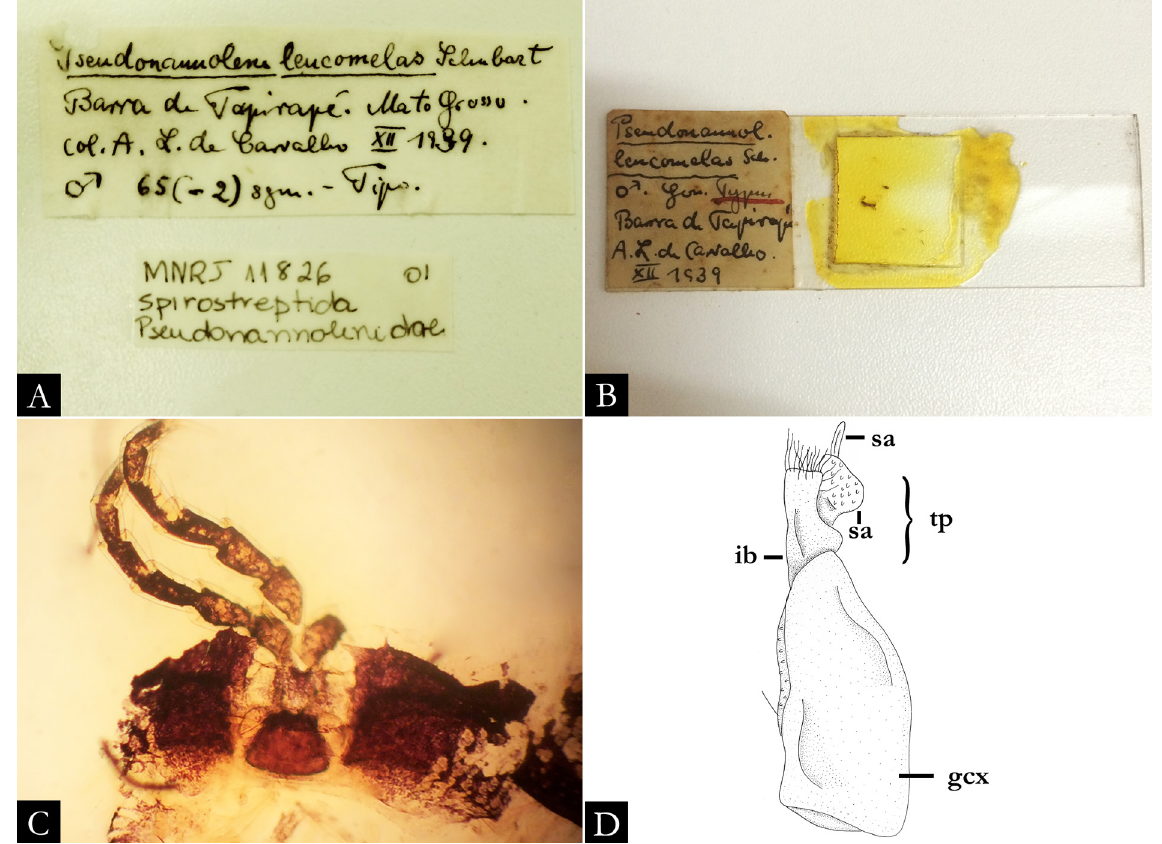
Fig. 82. Pseudonannolene leucomelas Schubart, 1947 , males. A . Original labels of type material (MNRJ 11826). B–C . Midbody ring of holotype (MZSP), in ventral view, mounted on microscope slide. D . Schematic drawing of left gonopod in anal view (modified from Schubart 1947: figs 33–34). Abbreviations: see Material and methods. Images not to